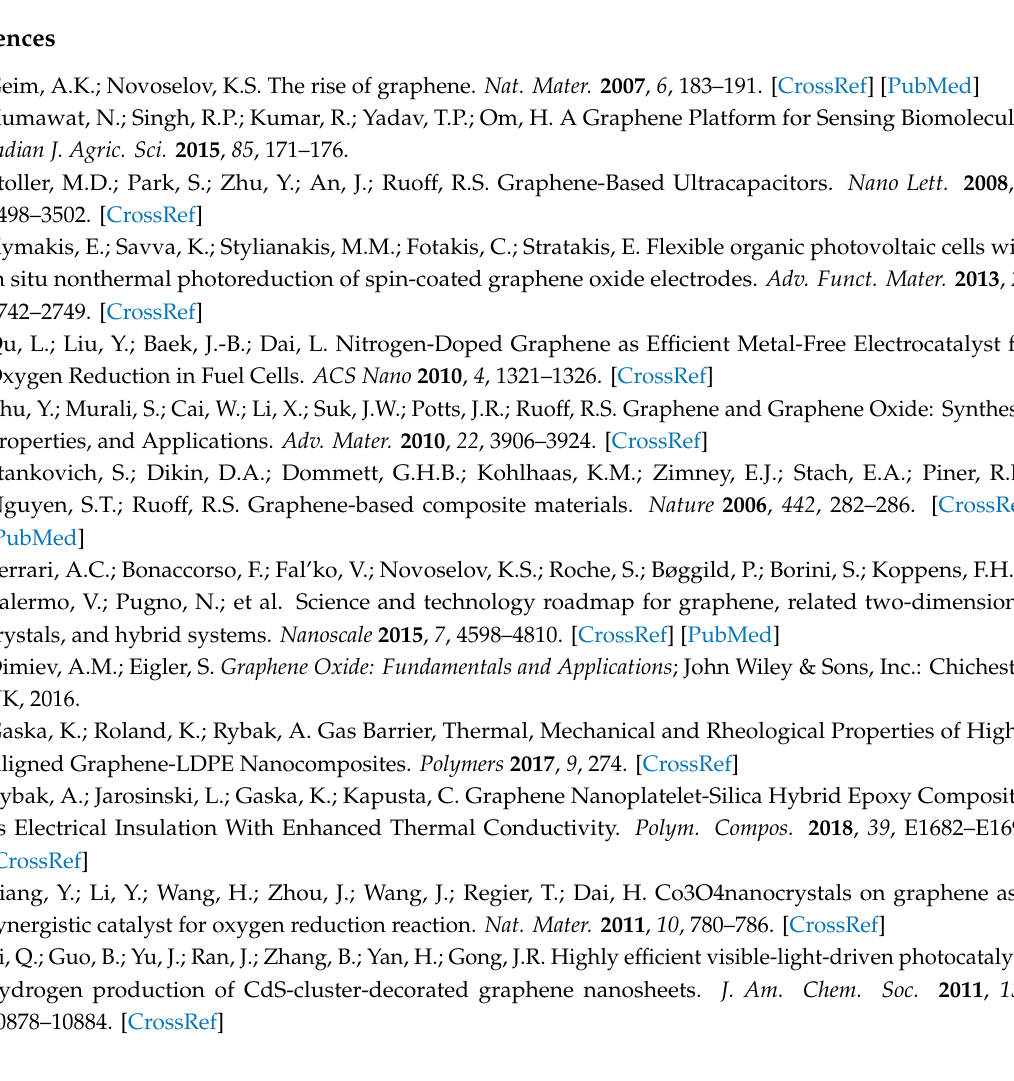
Figure S1. Example analysis of nanoparticle density on sample CRGO@AuNB_1 (a,c) and CRGO@AuNB_2 (b,d). Red marker on chart a and b indicates where the measured object’s area becomes smaller than average bipyramid surface area times 0.5. Green lines on TEM images c and d indicates graphene area taken into account during density calculation, while red lines mark areas completely excluded due to contrast / quality issues. See Section 2 of the main text for more details.; Figure S2. SEM micrograph of gold nanorods on CRGO.; Figure S3. SEM micrograph of gold bipyramids on CRGO.; Figure S4. SEM micrograph of gold nanostars on CRGO.; Figure S5. SEM micrograph of gold nanotriangles on graphene.; Figure S6. XPS spectra of GO, ARGO, and CRGO along with calculated elemental composition.; Figure S7. FT-IR spectra of